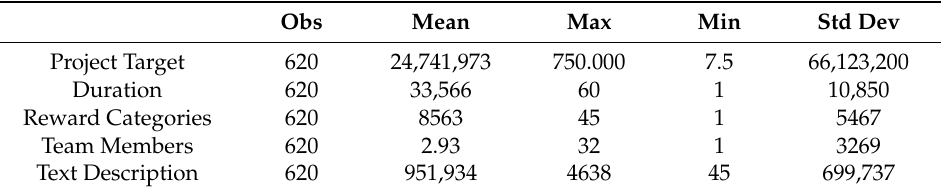
Table 2. Descriptive statistics of numeric